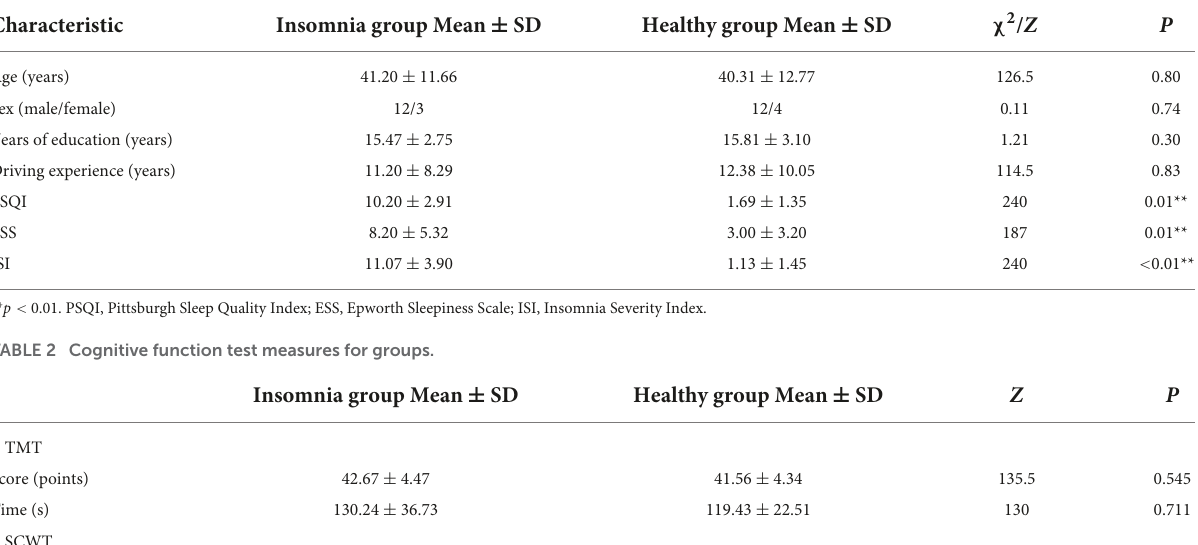
TABLE 1 Means ( ± SD) of participant characteristics.